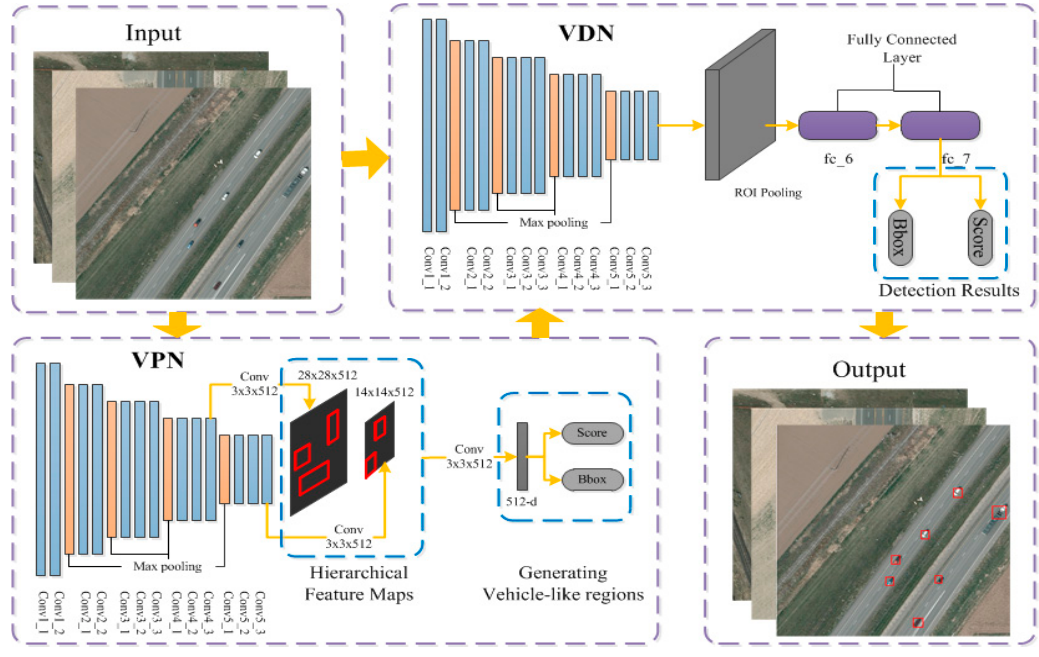
Figure 1. Framework of the proposed model.